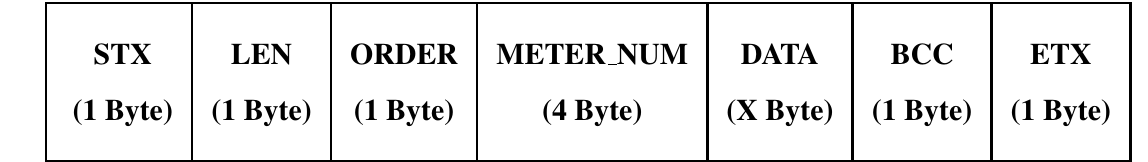
Figure 3. General structure of a transmission/reception